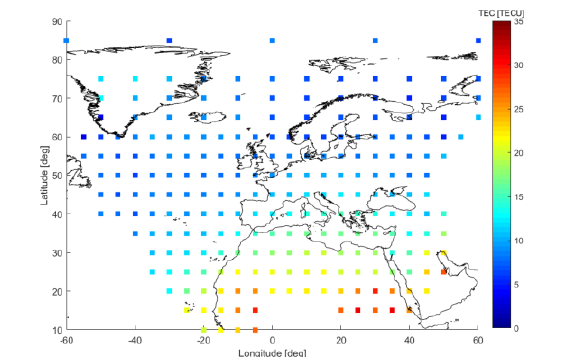
Figure 3. EGNOS TEC map at 13:45